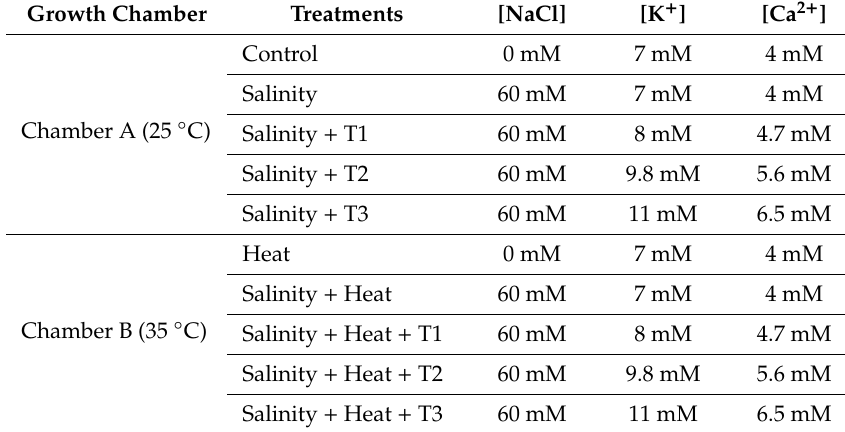
Table 1. Nutritional and environmental temperature treatments applied in the preliminary experiment to the tomato plants in order to select the most significant nutritional treatment for further